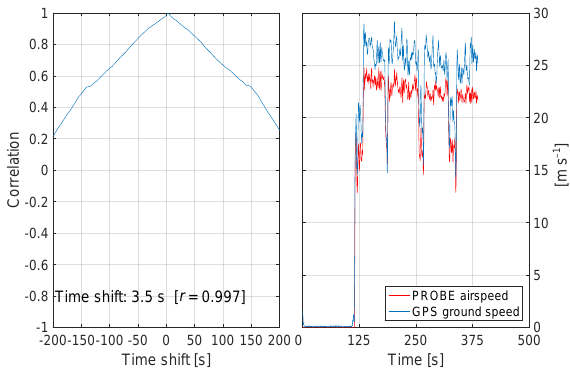
Figure 5. Example of the cross-correlation analysis between the GPS ground speed and the 5HP airspeed for one of the SUMO flights, with correlation coefficient and time shift in the left panel and time series of 5HP airspeed and GPS ground speed after syn- chronization in the right panel. The data are for flight no. 41 on 27 June at